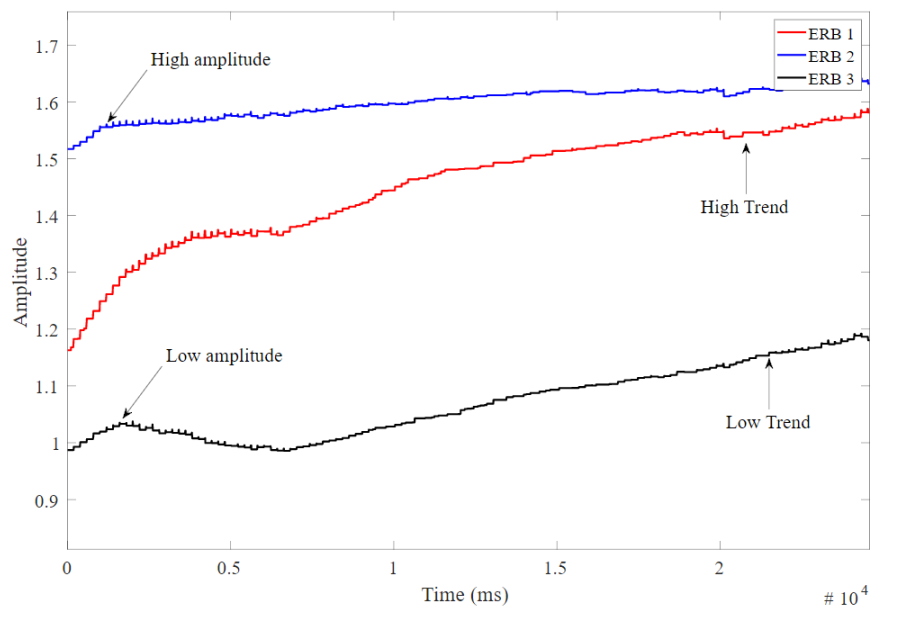
Figure 13. The amplitude change over time for three different band